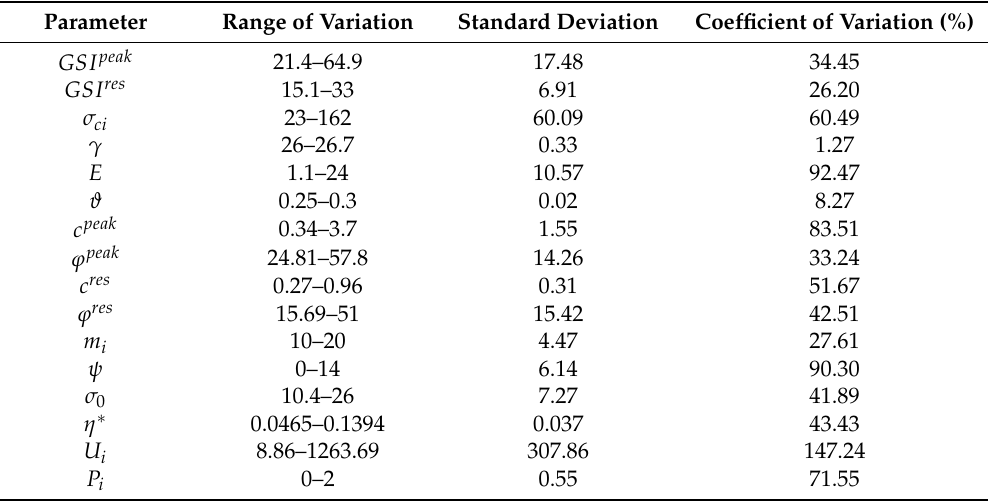
Table 1. Input and output parameters and their range of variation used in the prediction of the P i (Mohr–Coulomb case). Parameter Range of Variation Standard